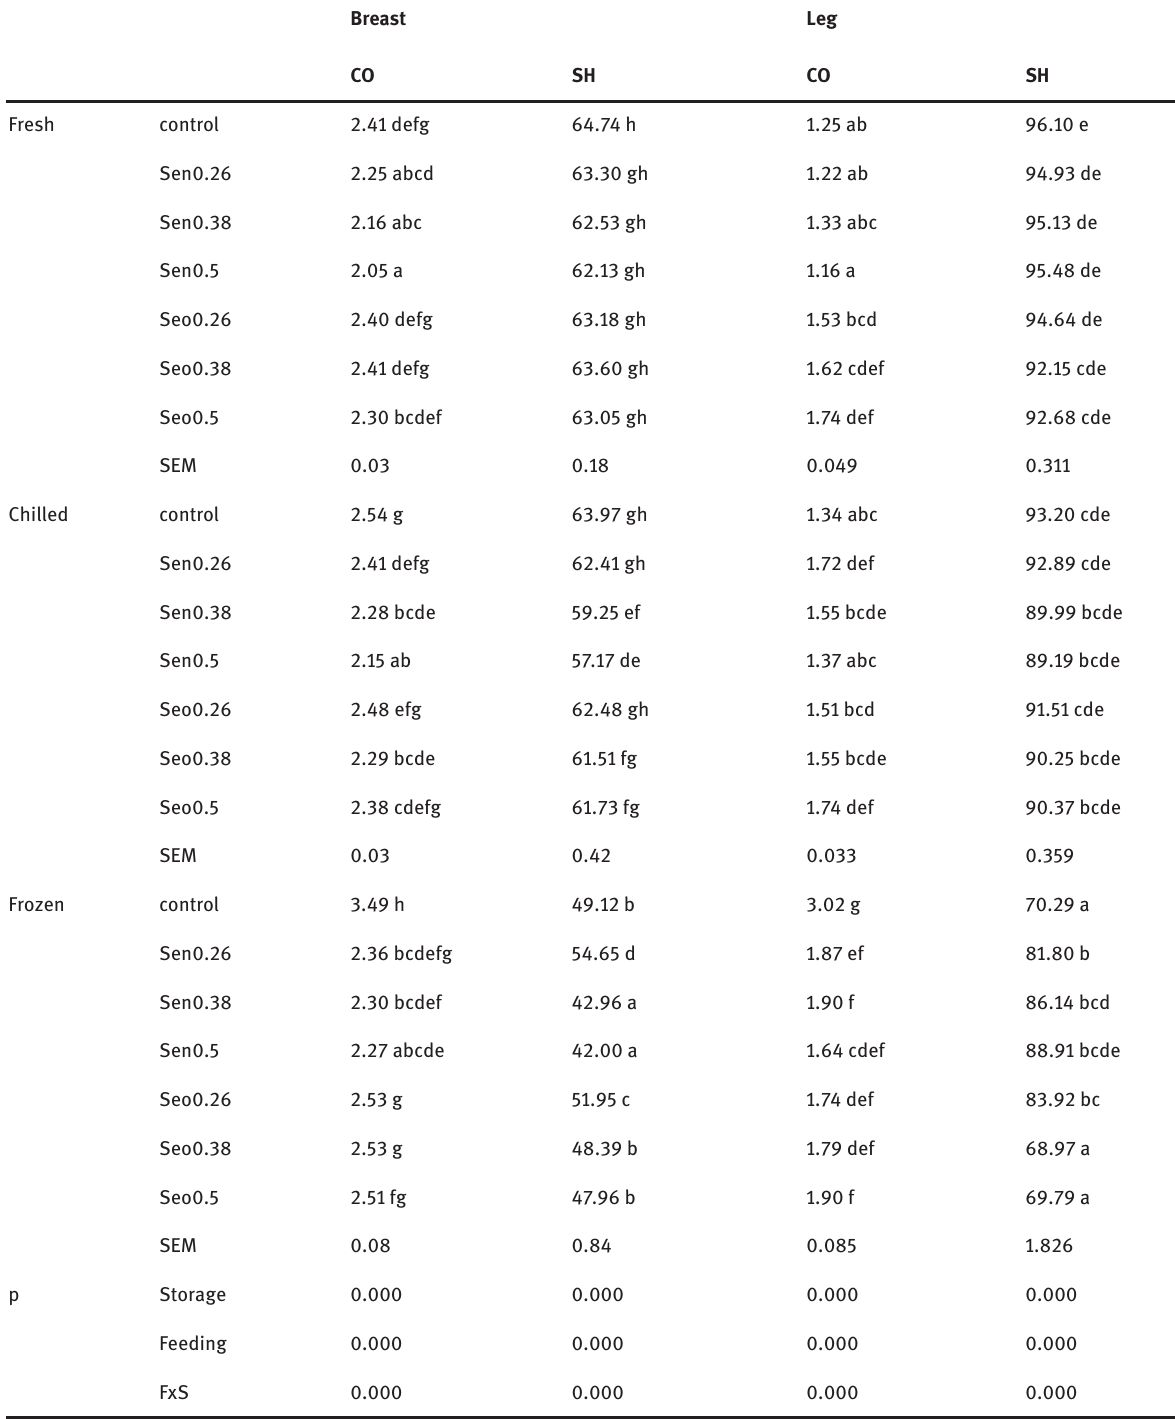
Table 1: Carbonyl and sulfhydryl groups content in breast and leg chicken muscles after dietary modulation with selenium.